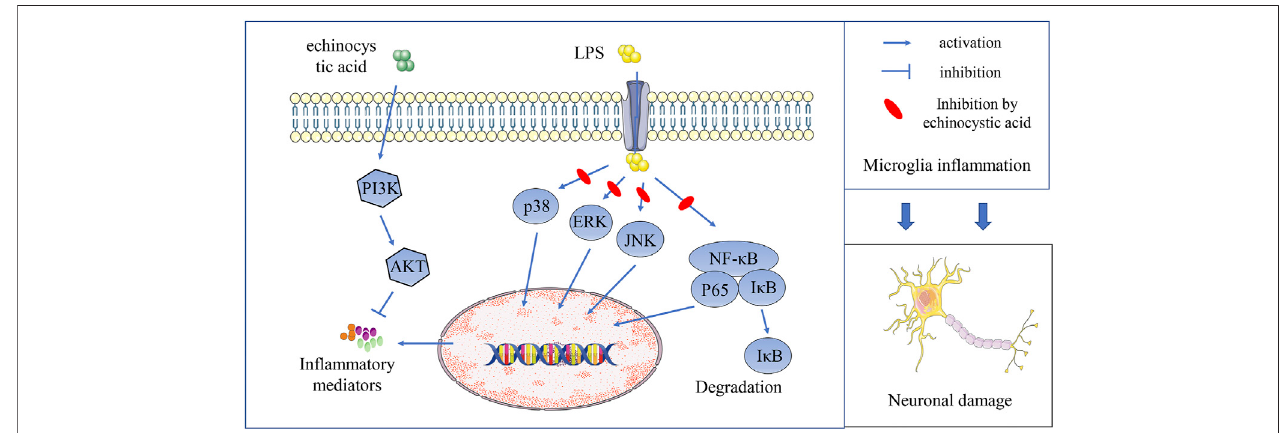
FIGURE 9 | EA inhibits neuroin fl ammation and exerts neuroprotective effects by activating PI3K/Akt signaling and inhibiting NF- κ B and MAPK signal